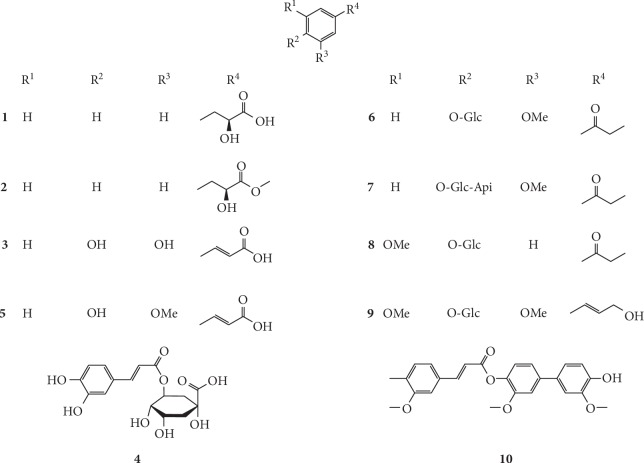
Structures of phenylpropanoids in G. littoralis.